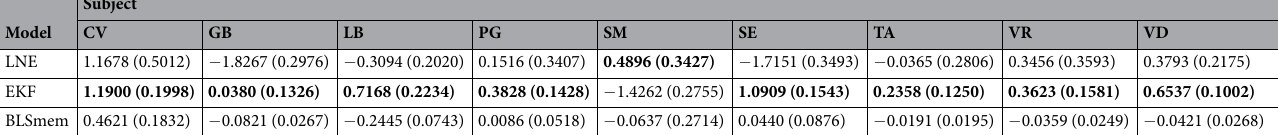
Table 1. Predictive log likelihood ratio for each model and subject. For each subject, the model with the highest predictive log likelihood is shown in bold. All log likelihood ratios were all smaller than 2 and consistent with what is expected based on simulations of each model (Supplementary Figs 7, 9 and